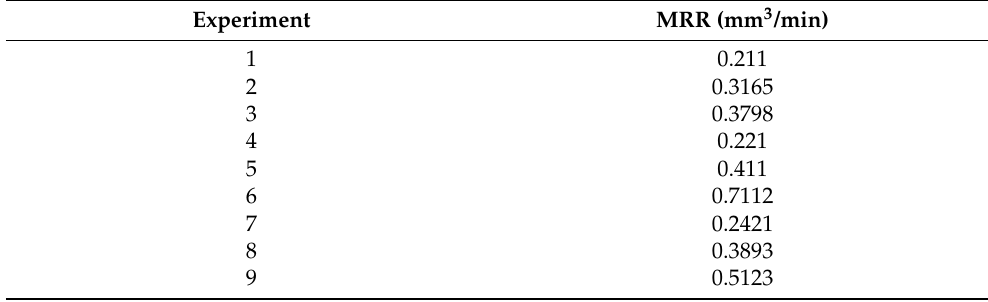
Table 9. MRR for AISI 1045 medium carbon steel.